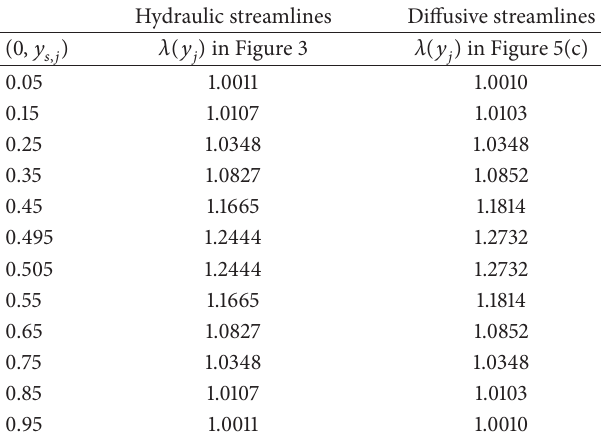
Table 5: Hydraulic and diffusive streamline comparison: in-line array of circles, 𝜙 = 0.71 . Flow is from left to right. (0,𝑦 𝑠,𝑗 ) indicate the starting location of the 𝑗 th